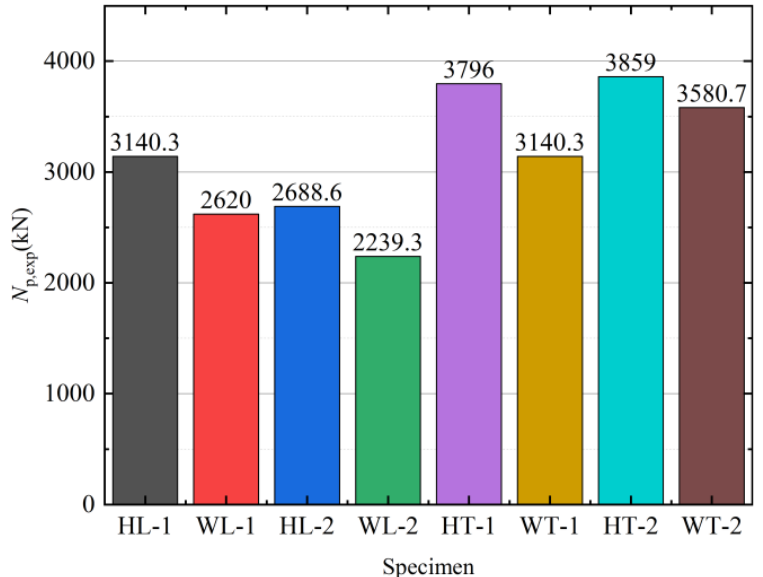
Figure 11. The peak load of test specimens.